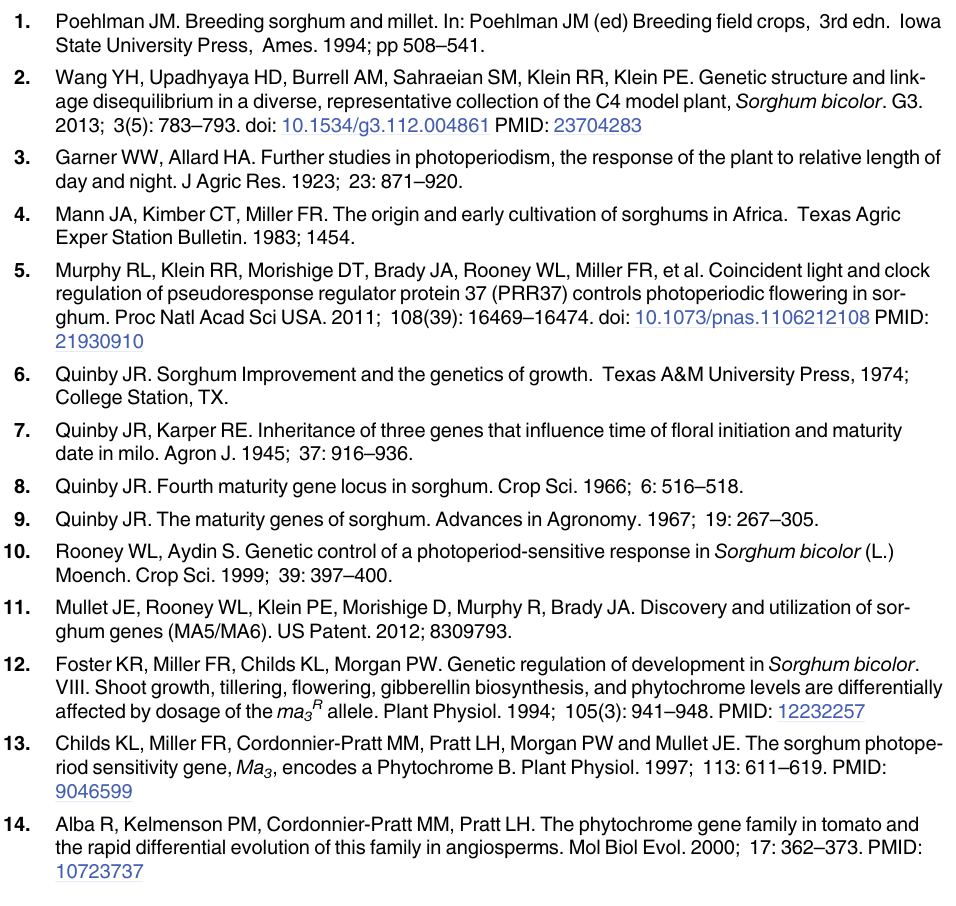
S4 Table. Haplotypes detected in this study. S5 Table. Genetic diversity of Ma3 gene respective region. S1 Fig. Neighbor-joining tree constructed based on the sequence data of the entire Ma 3 re- gion of all the landraces and wild